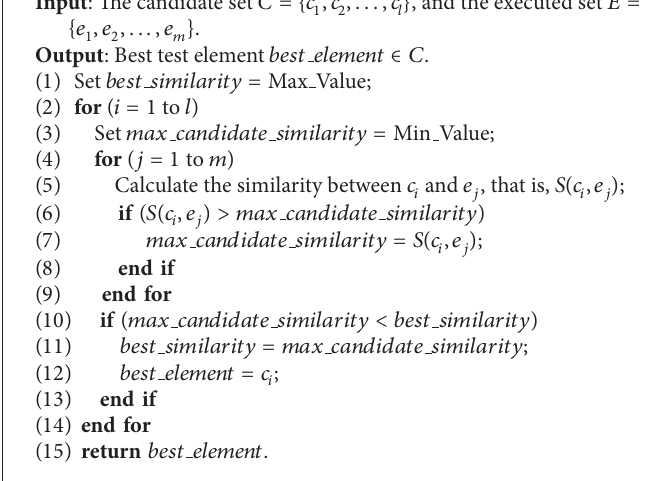
Algorithm 1: Select the best test element based on similarity (BTES).